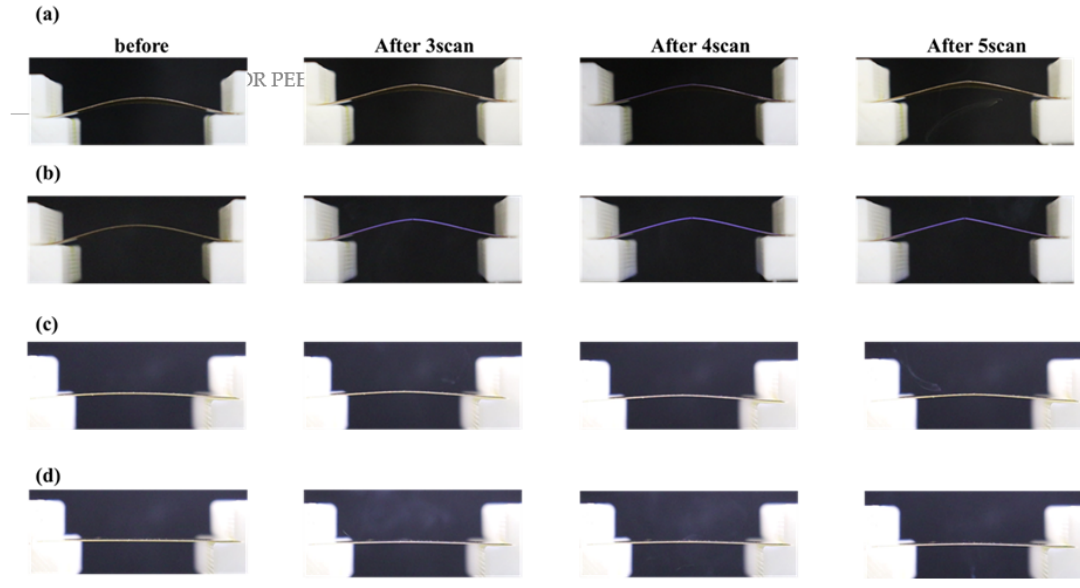
Figure 4. Images of the samples applying a fine curvature by pushing the sample in the preliminary preparation before laser processing and after scans: ( a ) with objective lens, ( b ) F-theta lens (push length: 1 mm), ( c ) F-theta lens (push length: 0.5 mm), ( d ) F-theta lens (push length: 0.1 mm).